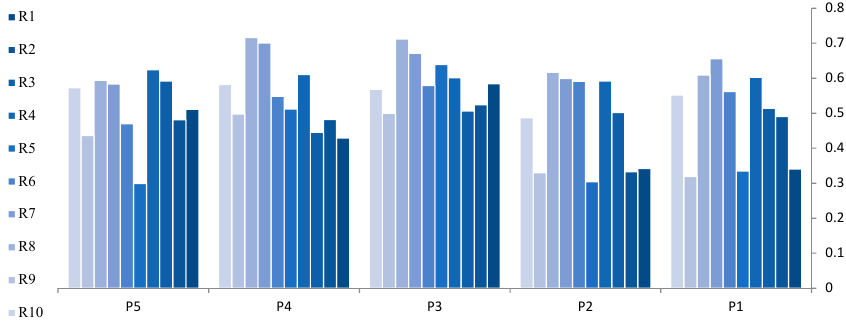
Figure 6. The status of 10 different risks in each investment project .